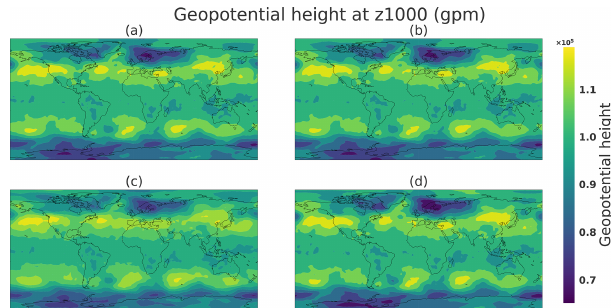
Figure 25. Generations obtained by radial interpolation in the latent space. Panel (a) is the image corresponding to a randomly drawn la- tent vector A (two-norm: 7.69), (b) is its projection onto the mean of the same direction A (two-norm: 8.0), and (c) and (d) are the projection onto, respectively, inferior A − (two-norm: 5.87) and su- perior A + (two-norm: 10.12) 1% quantile (see Fig.